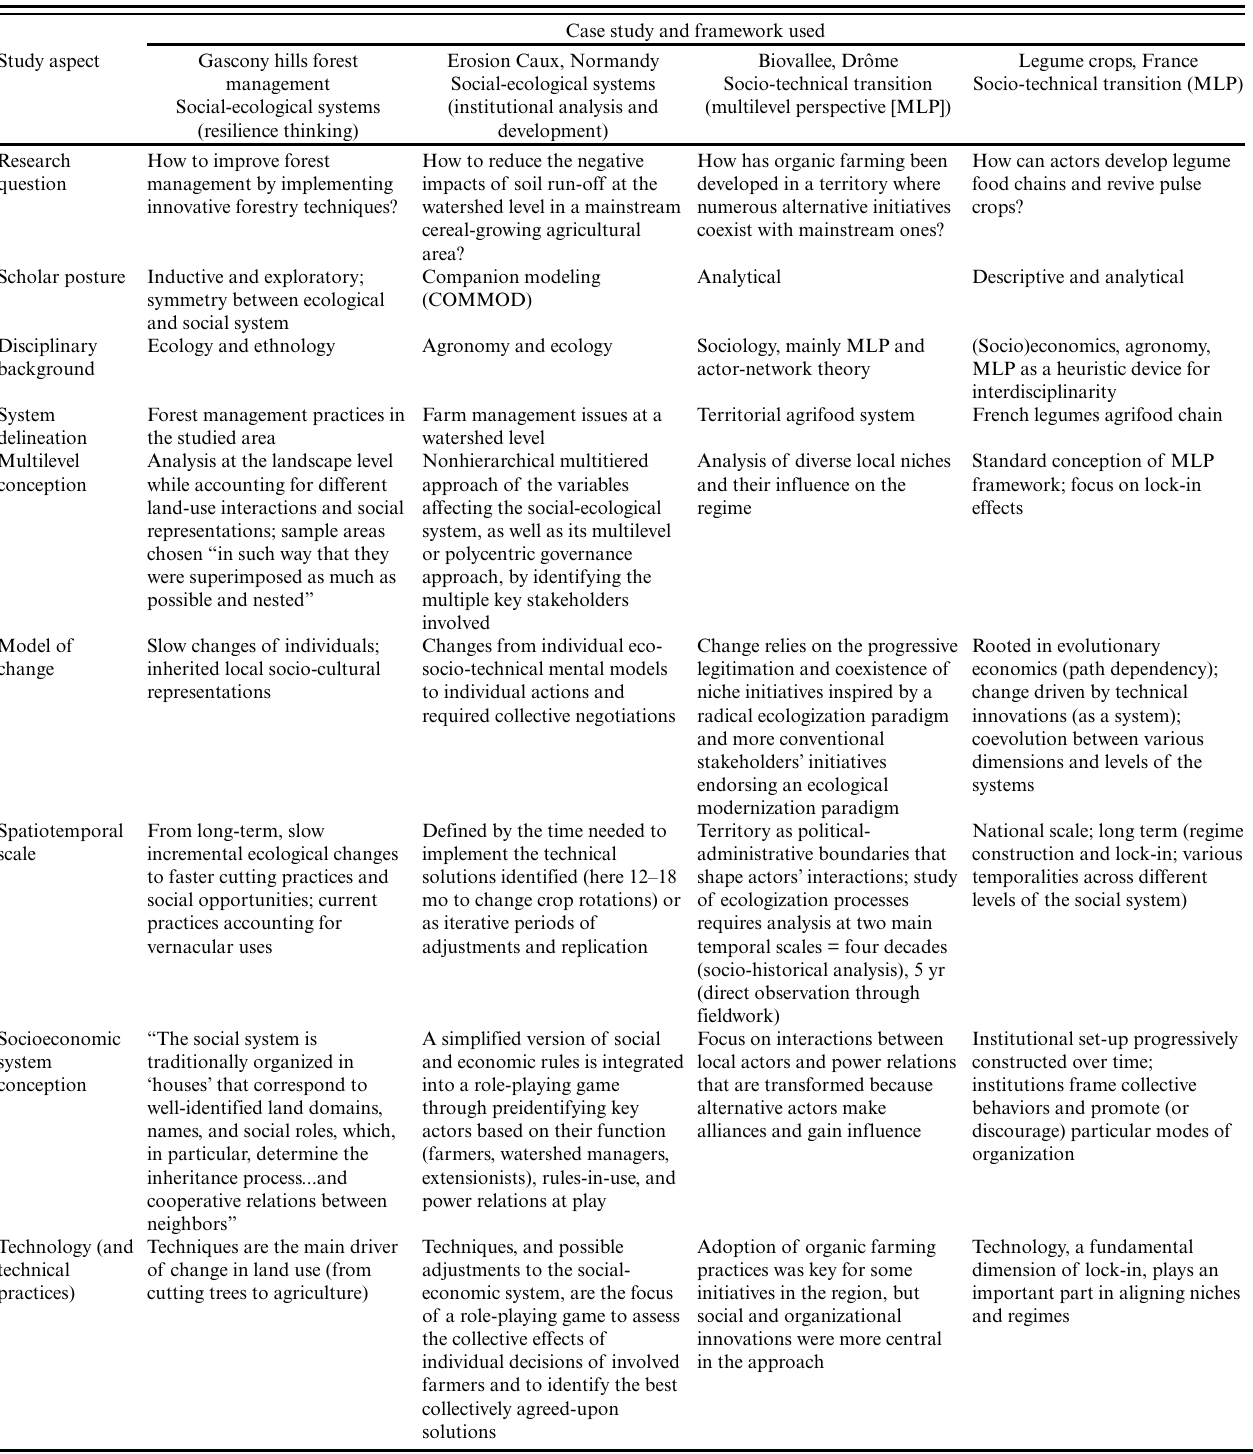
Table 2. Comparison of agroecological transition